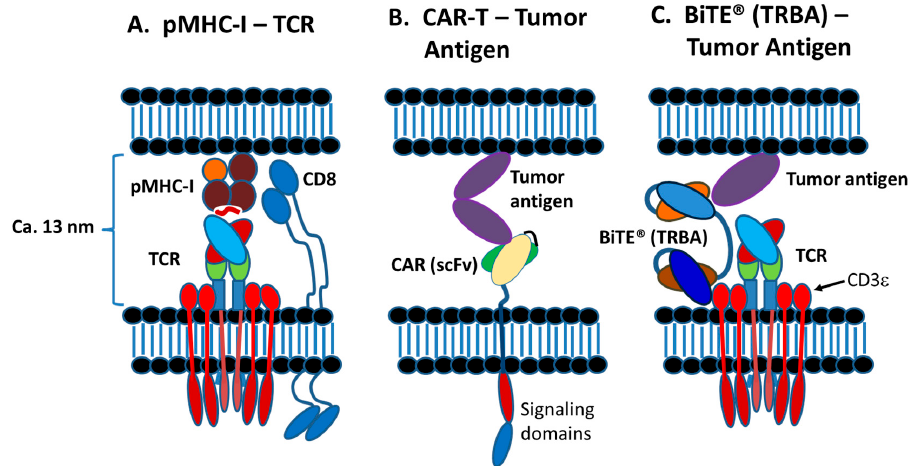
Figure 6. Diagram of the T-cell receptor complex. Diagram of the molecules driving synapse formation in pMHC-1/TCR T-cell/APC interactions, in CAR-T/target cell interactions and in TRBA-induced T-cell/target cell interactions. ( A ) Classic TCR/pMHC-1 type of interaction with a membrane to membrane spacing in the range of 13 nm [119]. ( B ) scFv-based CAR-T cell binding to tumor antigen on target cell. ( C ) BiTE ® binding to CD3 ε on T-cell and to tumor antigen on target cell to bring the cells into close proximity to form the cytolytic synapse.